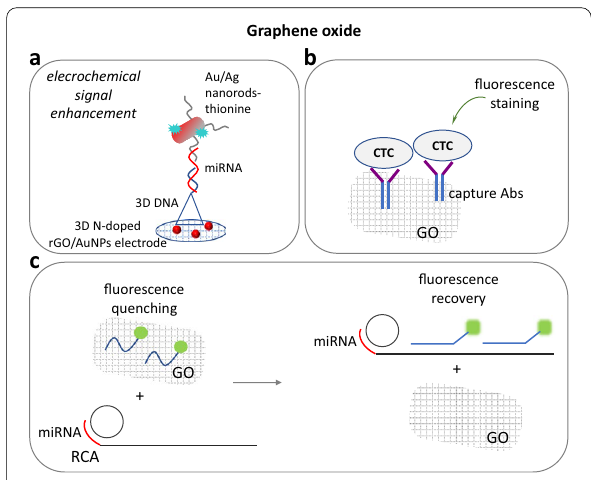
Fig. 2 a Electrochemical detection of miRNA based on gold and silver nanorods and the reductive compound thionine. The overall structure is captured on the electrode’s surface via a nitrogen-doped reduced GO/AuNPs/tetrahedral DNA nanostructure. b An antibody-reduced GO for CTCs sensing. c A fluorescent biosensor based on fluorescence quenching/recovery by GO using fluorescent DNA probes and rolling circle amplification (RCA) triggered by miRNA target. GO graphene oxide, CTCs circulating tumor cells, AuNPs gold